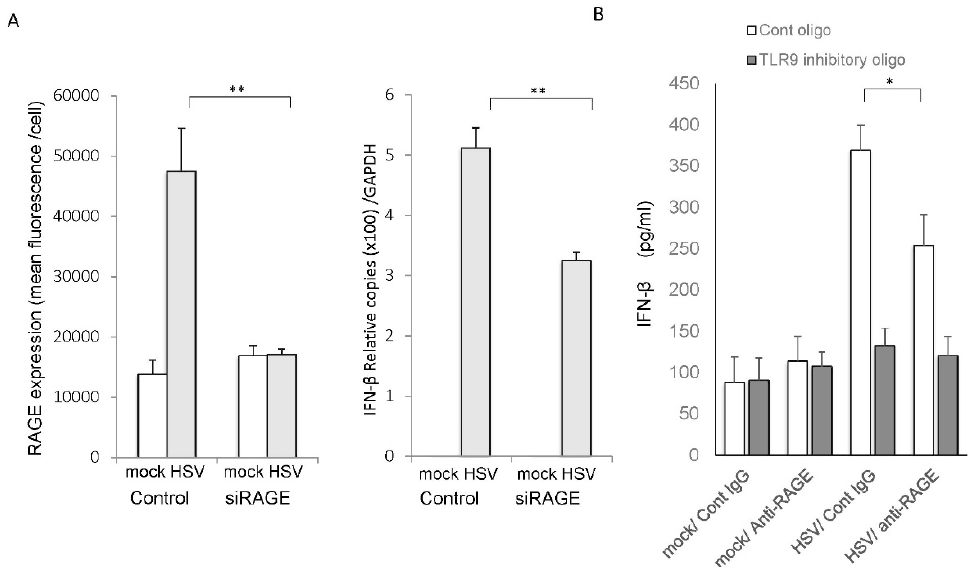
Figure 8. Role of RAGE and TLR9 in the interferon- β production by HSV-1 infection of corneal endothelial cells. ( A ) HCEn cells were transfected by siRNA of RAGE or control siRNA, and they were assessed for cell surface expression of RAGE with or without HSV-1 infection (multiplicity of infection (MOI) 1. Plated cells were stained for the surface expression of RAGE, and 1300 cells in high powered field per group were assessed for total fluorescence intensity. Si RNA transfection abolished HSV-1-induced-RAGE expression. HCEn cells were infected by HSV-1 infection at MOI 1 and were assessed for the expression of the mRNA of interferon- β at 12 h by real-time RT-PCR. The HSV-1 infection induced-interferon- β mRNA were significantly impaired by the RAGE blockade using siRAGE. ( B ) HCEn cells were infected by HSV-1 and were as- sessed for interferon- β production at 24 h by ELISA. HCEn cells stimulated with HSV-1 infection at MOI 1 induced inter- feron- β which was significantly reduced by anti-RAGE antibody and abolished by TLR9 inhibitory oligonucleotide (2 µM). *: p < 0.01; **: p <0.001; n = 6.